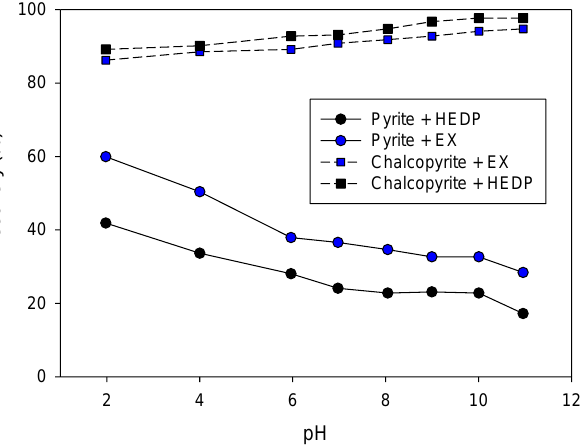
Figure 18. Flotation recoveries of chalcopyrite and pyrite as a function of pH using 2 × 10 −4 mol/L of HEDP or 2 × 10 −4 mol/L of EX as collector (adapted from Huang et al. [50]).